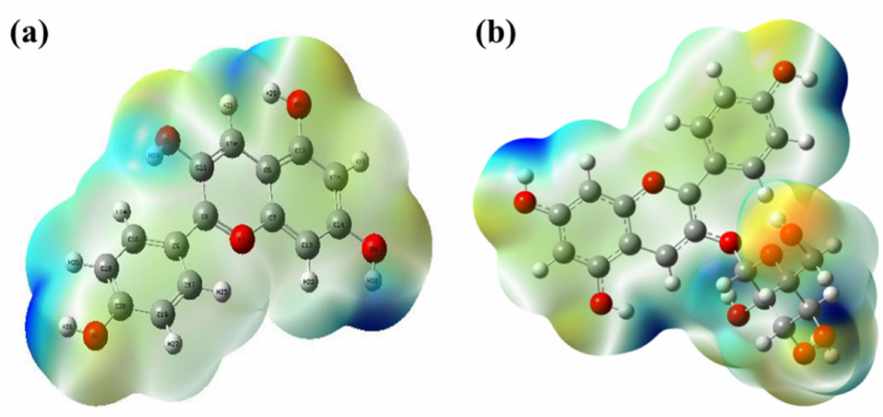
Figure 3. Molecular electrostatic potential (MEP) diagrams: ( a ) pelargonidin; and ( b ) pelargonidin-3-